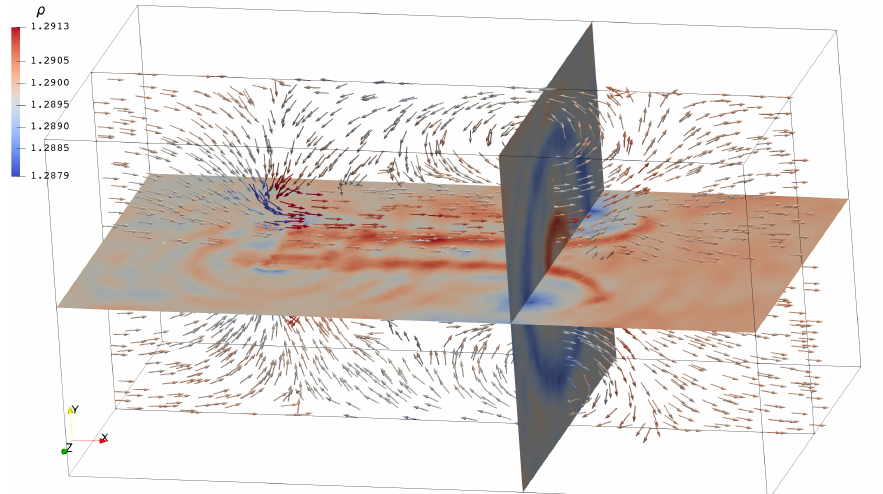
Figure 32. Third-order solution of Problem 7 at t = 1.